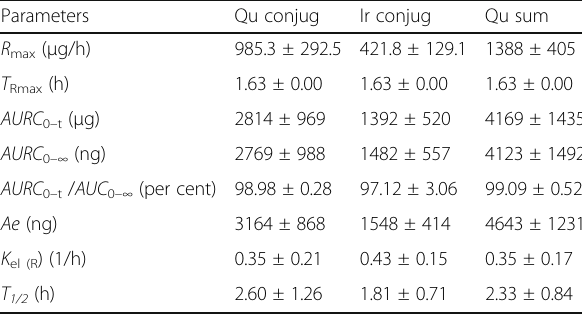
Table 3 Mean pharmacokinetic parameters of Qu in urine for 12 volunteers after intravenous administration of Corvitin®